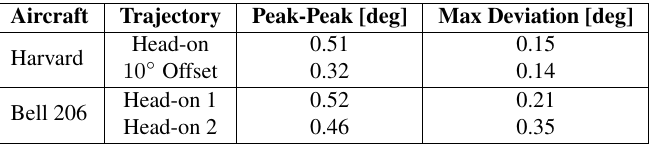
Table 3: Peak-Peak variation between predicted and measured virtual horizon proximity